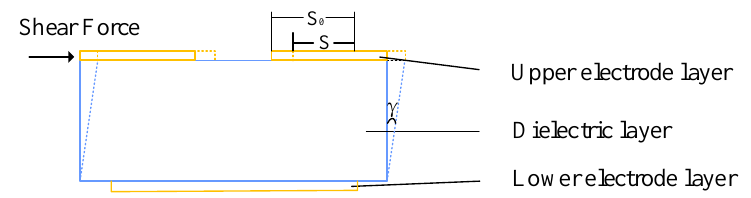
Figure 3. Tangential force testing diagram.